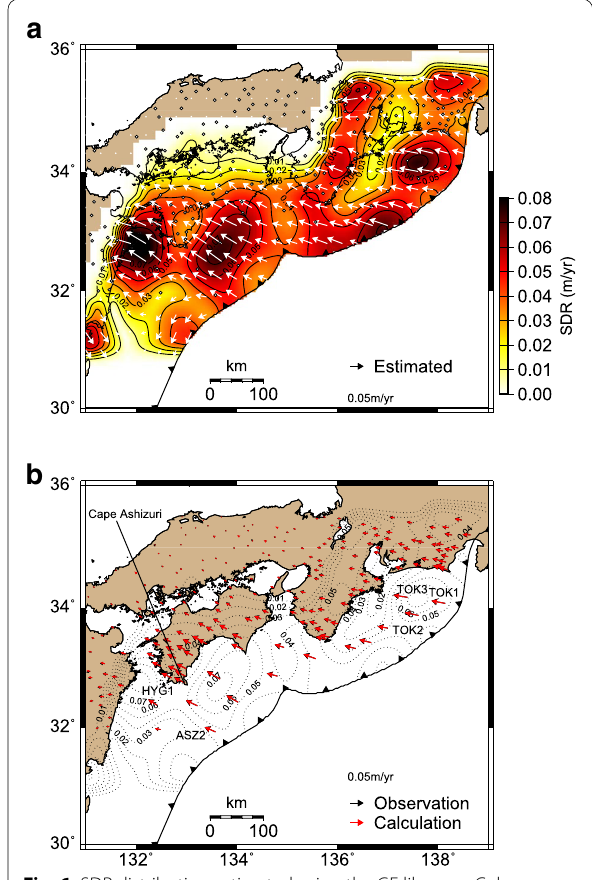
Fig. 6 SDR distribution estimated using the GF library. a Color contour and vectors of estimated SDR. The white dots denote the location of the observation. b Comparison of observed and calculated velocity in the observation stations. Dotted contour lines denote the norm of the estimated SDR